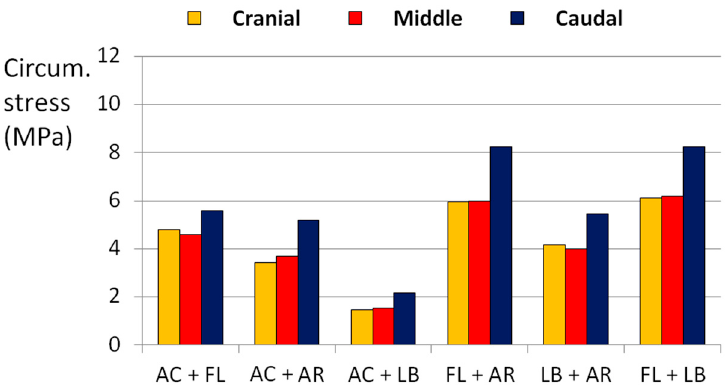
Figure 8. Circumferential (Circum.) stress generated in the POST-LAT1 section by combined loads. AC means axial compression, FL means flexion, AR means axial torsionrotation, LB means lateral bending.